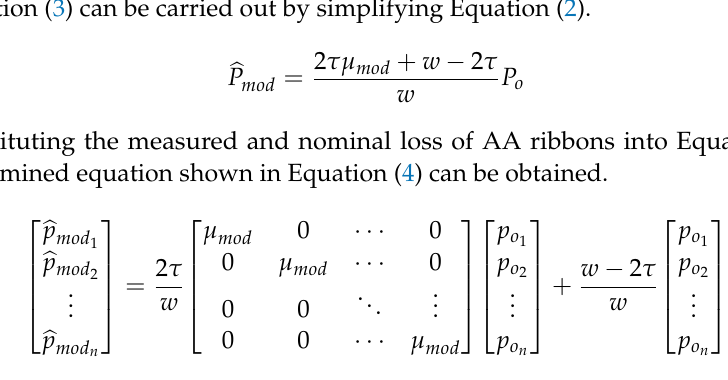
Figure 16. Schematic diagram of the loss model of the sample. Equation (3) can be carried out by simplifying Equation